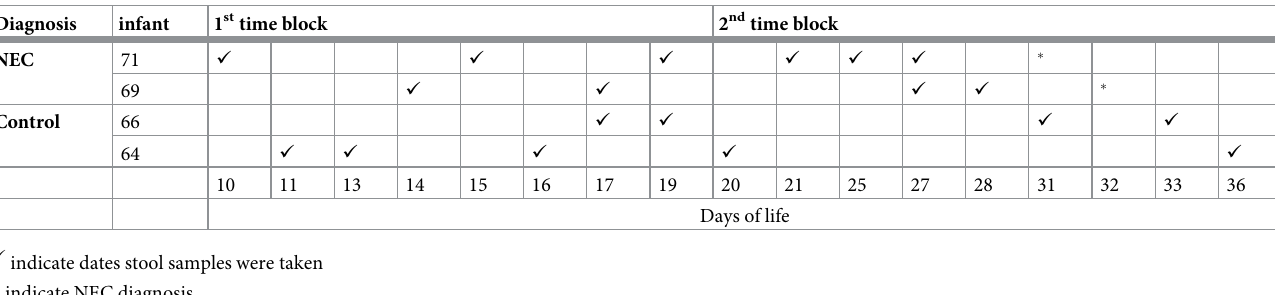
Table 2. Infant stool sampling